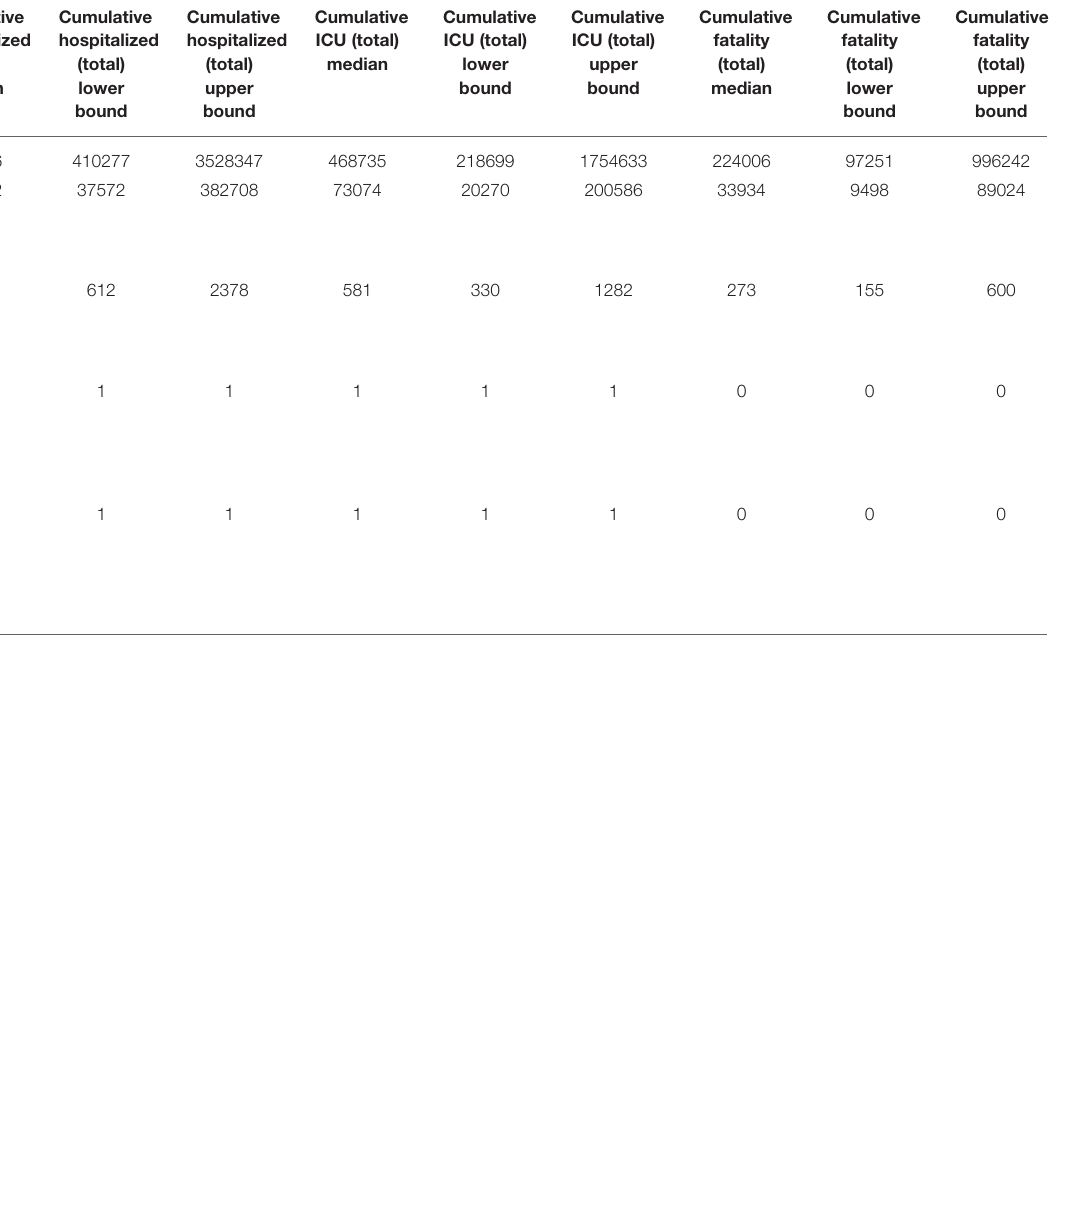
TABLE 3 | Data from COVID-19 Scenarios regarding the number of individuals in the different compartments of the model (simulation performed summer